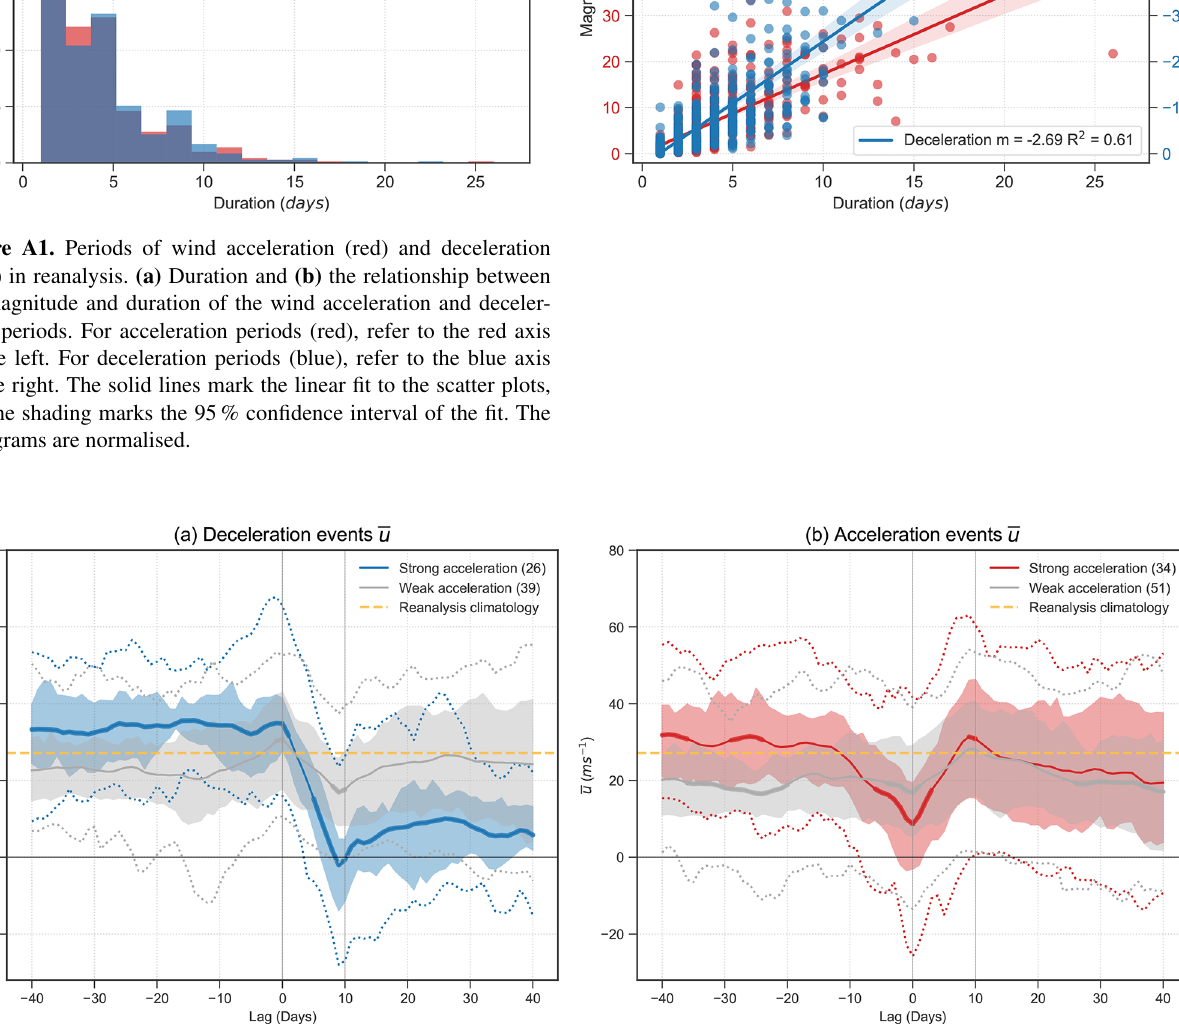
Figure A2. Time evolution of daily values of u for the strong decel- eration (blue) and acceleration (red) events in reanalysis. The solid line shows the mean value, and the bold line indicates where the composites are significantly different from the reanalysis climatol- ogy using Student’s t test. Weak events are composited separately and shown in grey. The dotted lines in the corresponding colours in- dicate the 5th and 95th percentiles of the composite, and the shaded region indicates the 25th to 75th percentiles. The dotted yellow line shows the winter climatology u in reanalysis. The number in the brackets of the legend indicates the number of events in the com- posites. Lag is relative to the first day of the identified 10d